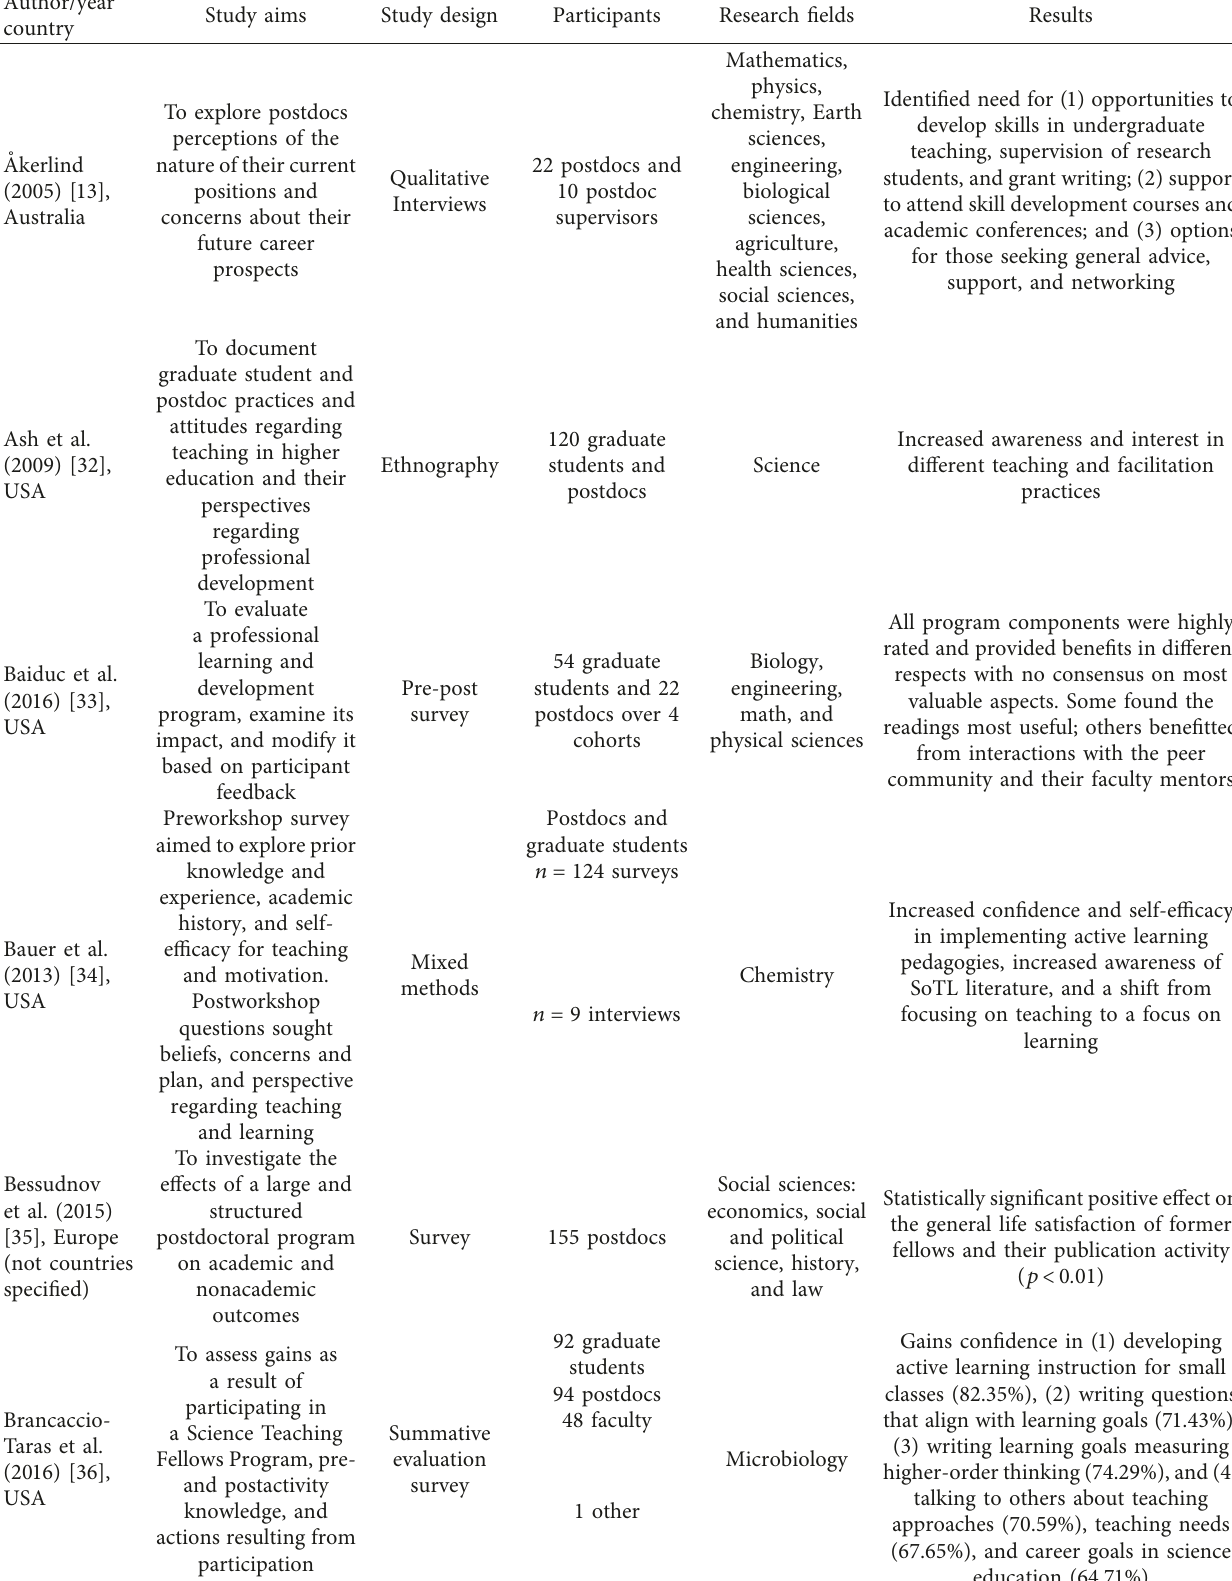
Table 3: Overview of studies about professional development and learning for